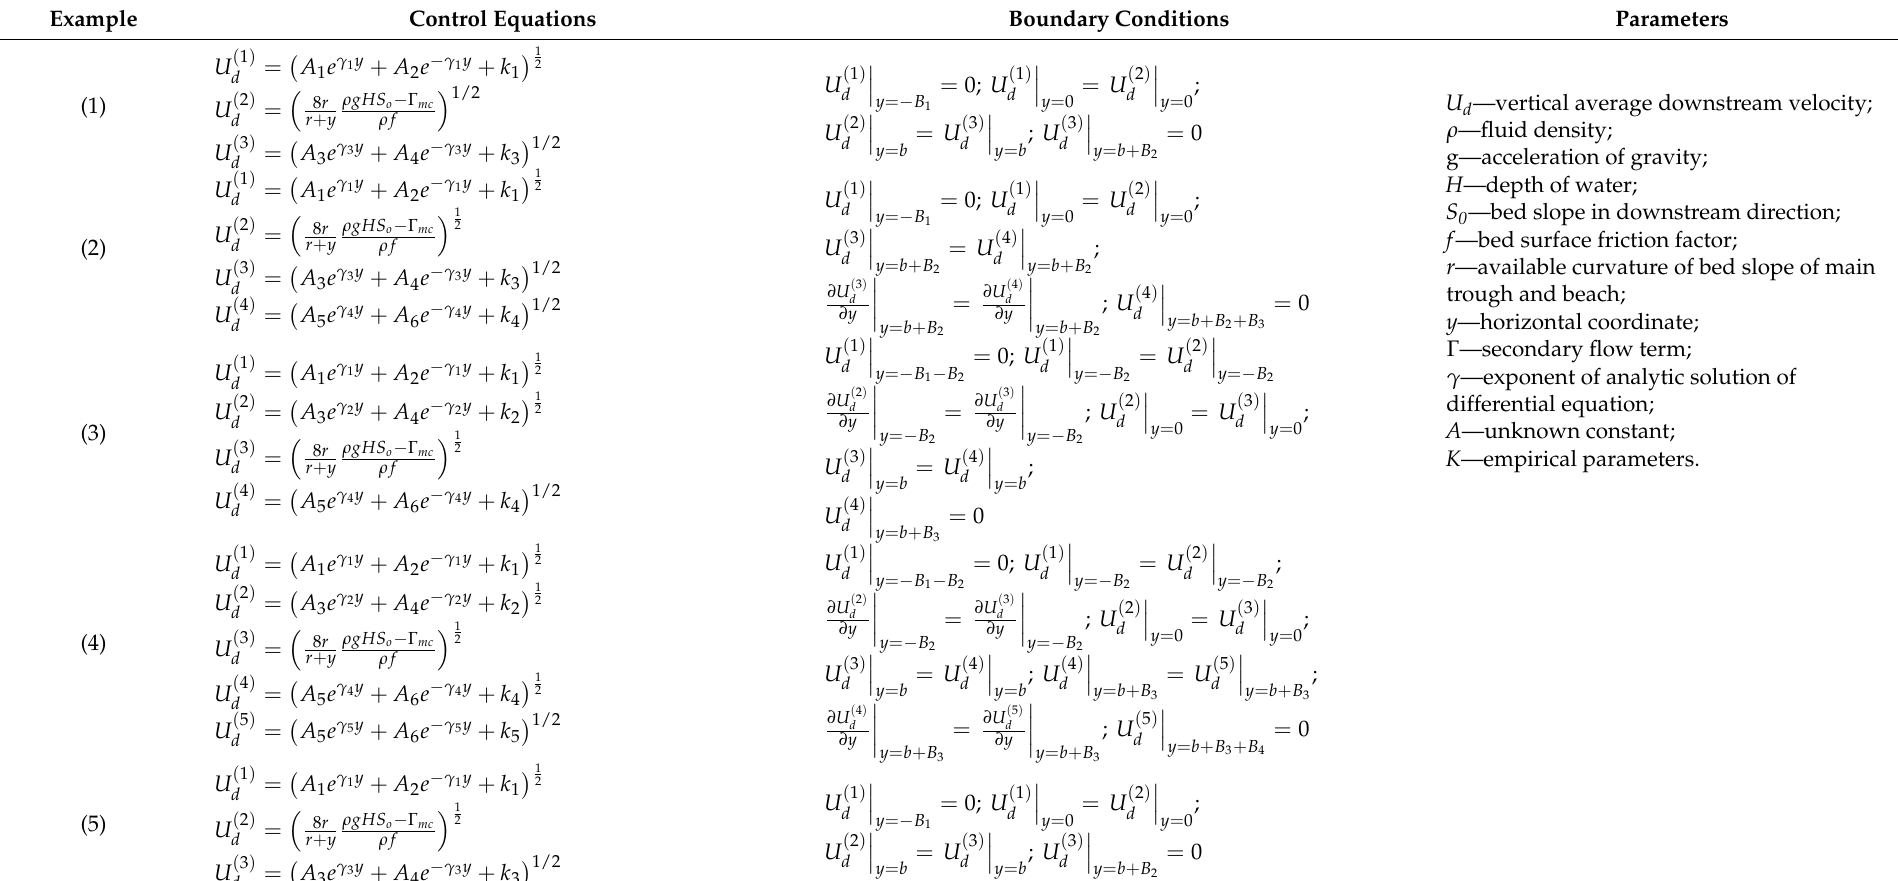
Table 2. Control equations and boundary conditions of five